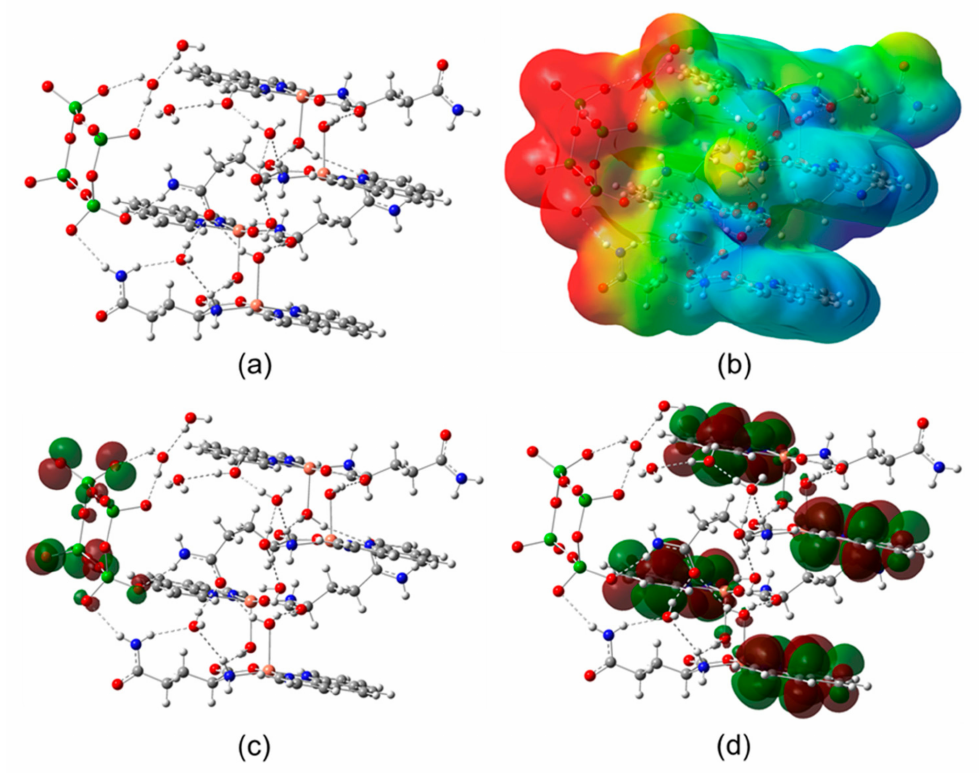
Figure 5. ( a ) Molecular structure, ( b ) molecular electrostatic potential (MEP), ( c ) HOMO isosurface, and ( d ) LUMO isosurface of Compound 1 at the B3LYP/Def2SVP-LANL2DZ level of theory using the ECP=LANL2DZ for V and Cu atoms in the PCM